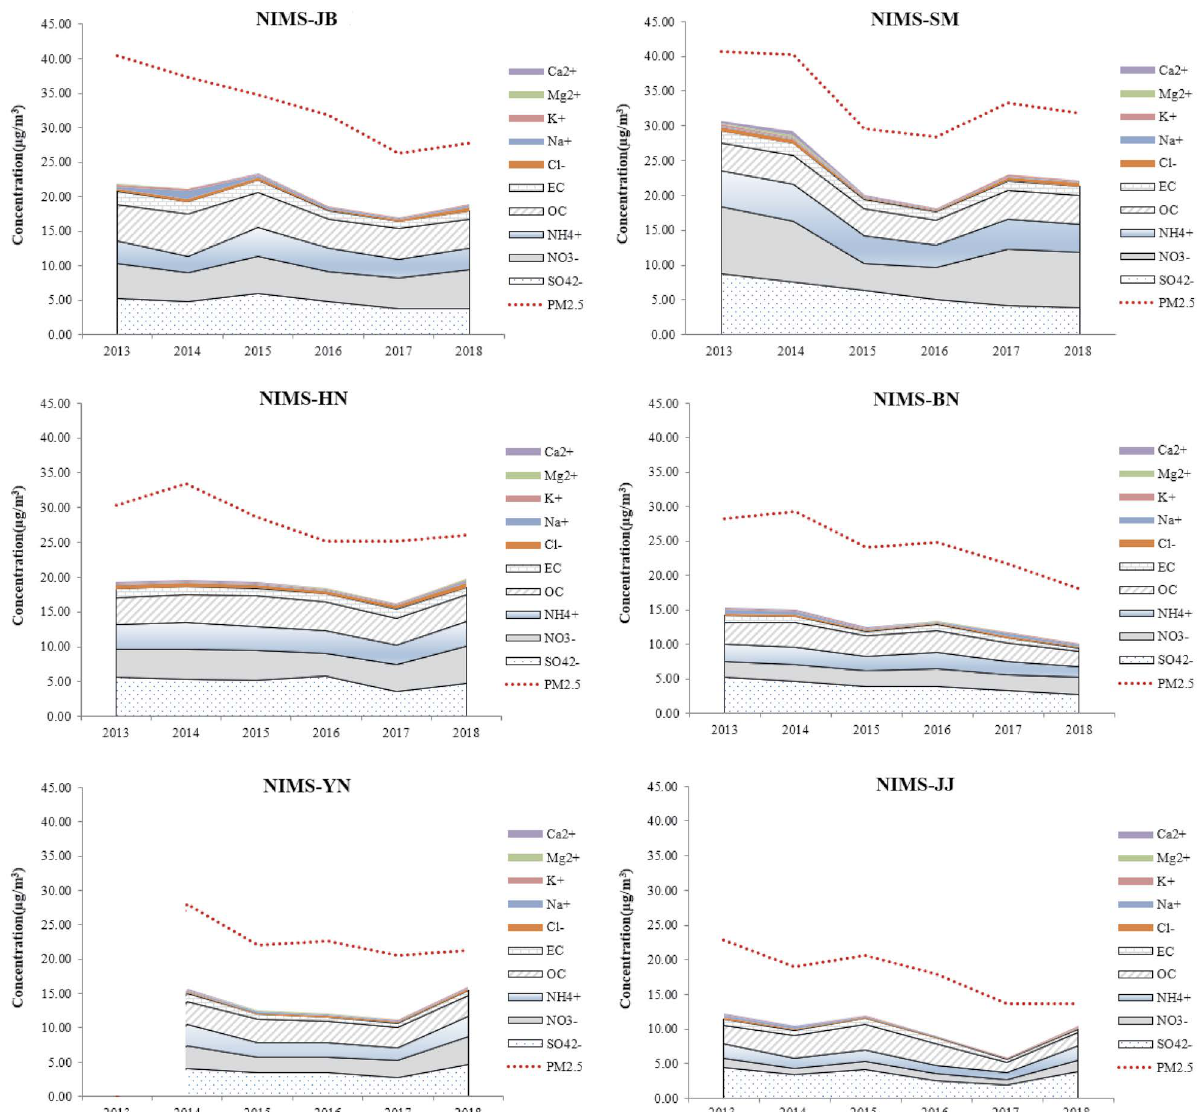
Fig. 7. Trends of annual average concentrations for 10 chemical species in PM